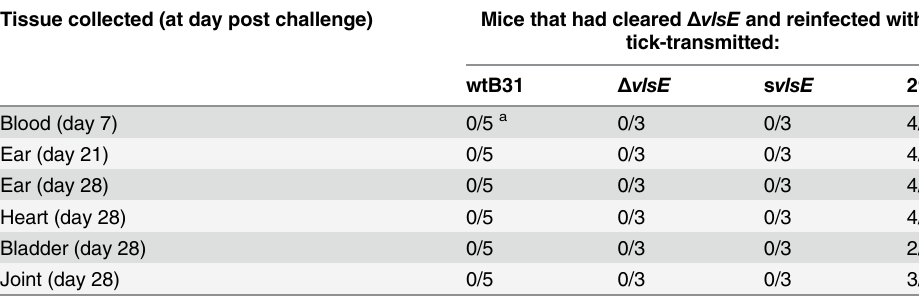
Table 5. Assessment of reinfection by tick-transmitted B . burgdorferi in P . maniculatus mice that pre- viously cleared in vitro -grown Δ vlsE spirochetes. Tissue collected (at day post